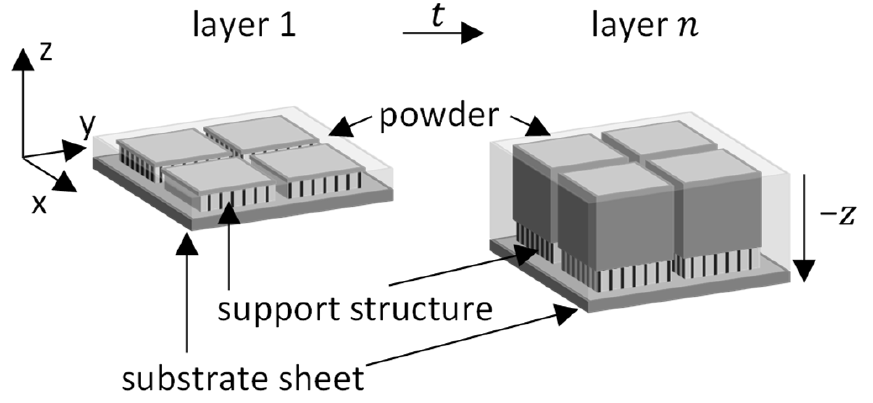
Figure 1. Illustration of the samples produced on removable substrate sheets. Cubes with an edge length of 10 mm were generated for the present investigation. The height of the applied powder layers was set to 60 µ m. The layers were molten, using the chess hatch with zig-zag vectors with a hatch distance of 210 µ m for all experiments. The chess pattern was shifted by 4.02 mm in the x-direction and by 5.44 mm in the y-direction for each new layer to reduce the directionality of the sample. The vectors inside the pattern were either parallel or perpendicular to the contour of the cube, as shown in Figure 2. Table 2 lists the applied parameters. The values of the absorptance η Abs were taken from Leis et al. [21], as the absorptance is influenced by the incident laser power P L and the diameter d b of the beam on the surface of the sample. The experiments were per- < 5200 W/mm for formed within the optimum process window 2000 W/mm < P L d b AlSi10Mg [24] and with P é clet numbers smaller than Pe = ( d b · v ) / κ ≤ 16/ π to match the case of three-dimensional heat flow [22–24], ensuring that the temperature distribu- tion could be approximated by Equation (5). The parameters were selected in such a way that the aforementioned requirements were met and the parts could be produced using